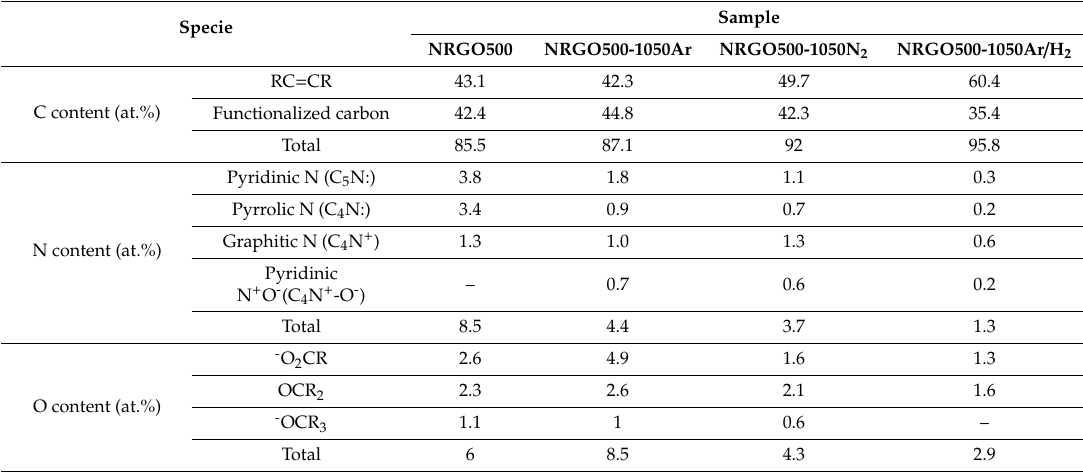
Table 3. Carbon, nitrogen, and oxygen atomic content (at.%, determined by XPS) present in NRGO500 after annealing this sample at 1050 ◦ C under Ar (NRGO500-1050Ar), N 2 (NRGO500-1050N 2 ), and Ar / H 2 (NRGO500-1050Ar / H 2 ). In all cases the contribution of the specific functionalities is included. Specie Sample NRGO500 NRGO500-1050Ar NRGO500-1050N 2 NRGO500-1050Ar / H 2 RC = CR 43.1 42.3 C content (at.%) Functionalized carbon 42.4 44.8